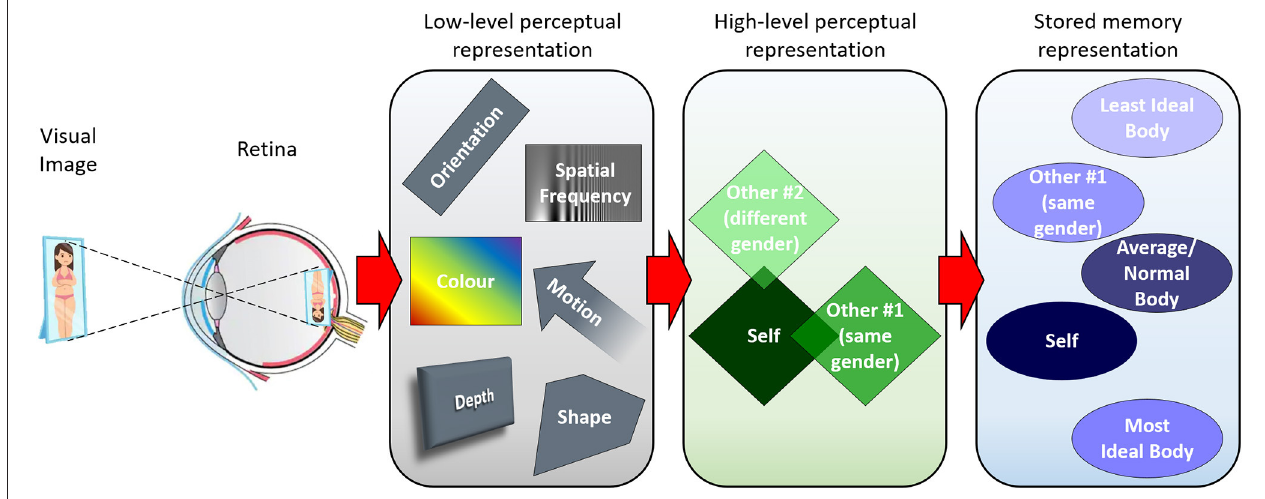
FIGURE 1 | A simple model of visual representations for bodies. Light from objects in the real world forms an image on the retina, where it is transduced into neural impulses. While the stimulus is present, fundamental visual properties are encoded (gray box) before the information is passed on to higher levels of processing where more complex properties are encoded (green box). Bodies perceived thus may then be stored in memory (blue box) for retrieval after removal of the visual